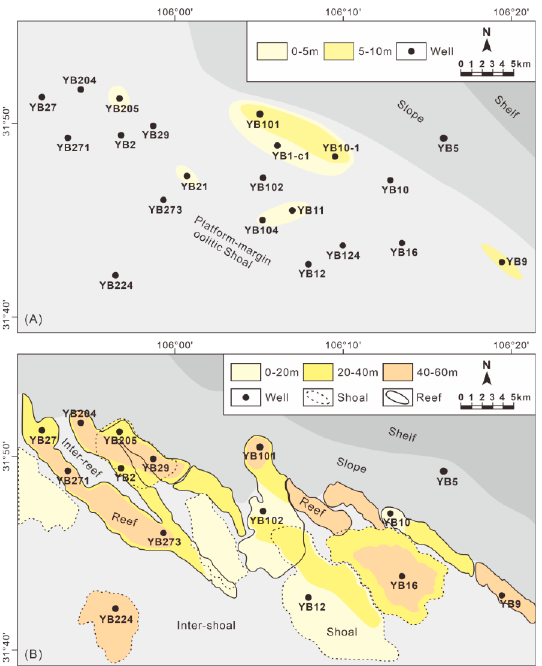
Figure 9. Distribution area and thickness of dolostones from T 1 f ( A ) and P 3 c ( B ) in the YB gas field. Note that the celestite samples are distributed in the northwest of the YB gas field.